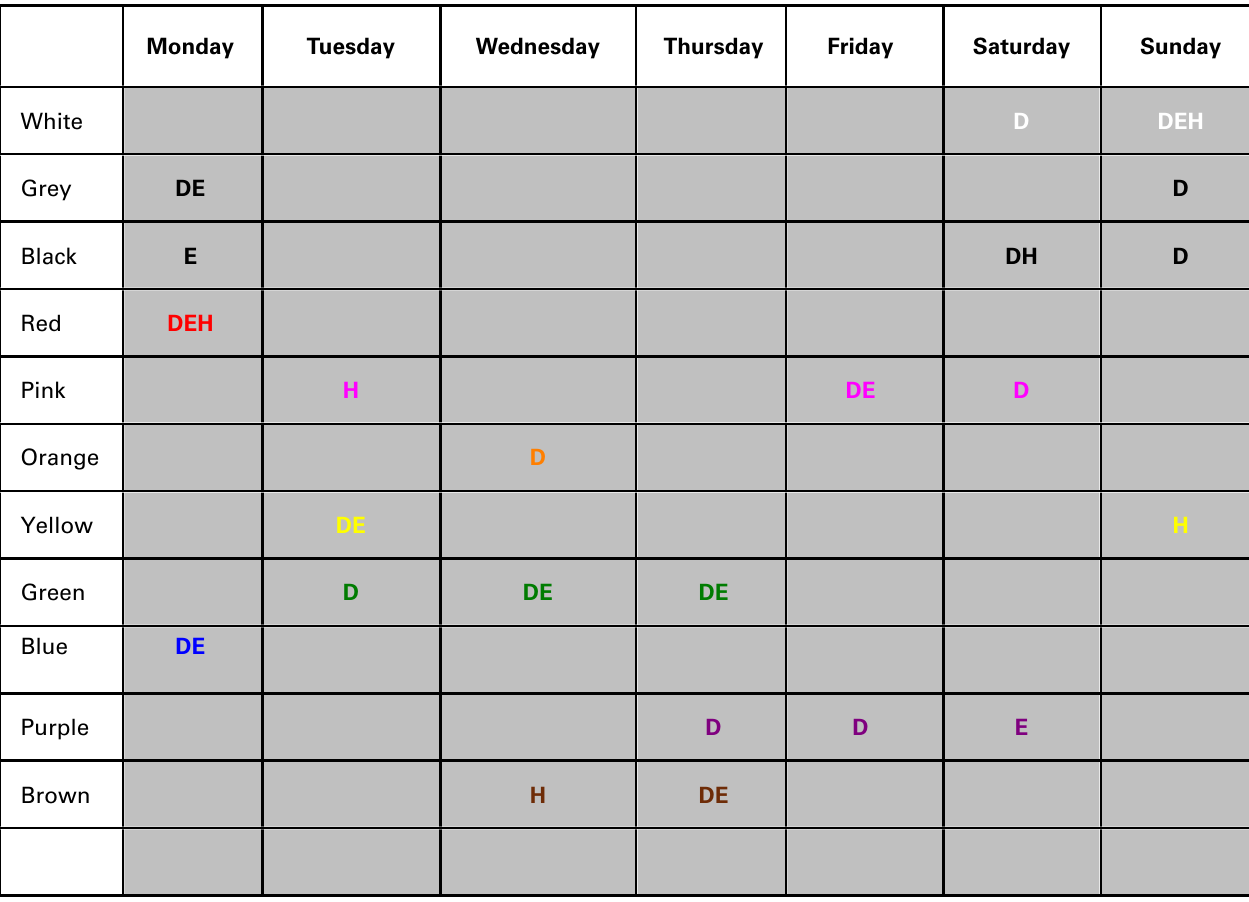
Table 3 | Colors for each of the weekdays that were significantly different from expected values (in a chi-test), in the Dutch (D) English (E) and Hindi (H) speaking participant